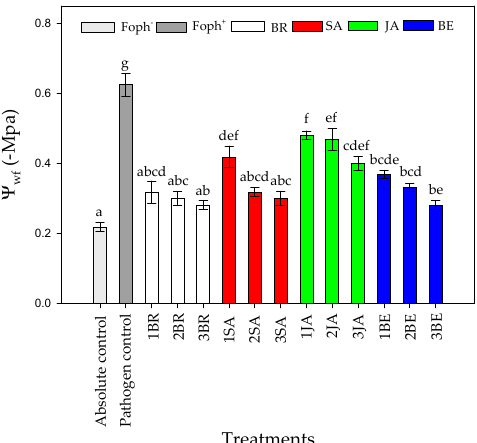
Figure 6. Effect of the different number of sprays (0, 1, 2, and 3 applications) of synthetic elicitors (Salicylic acid (SA), jasmonic acid (JA), Brassinosteroids (BR), or botanical extracts (BE)) on leaf water potential ( Ψ wf ) in Fusarium oxysporum f. sp. physali (Foph + ) infected cape gooseberry ( Physalis peruviana L.) plants at 50 DAI. Data represent the average of ten plants ± SE per treatment ( n = 10). Bars followed by different letters indicate statistically significant differences according to the Tukey test ( p ≤ 0.05).